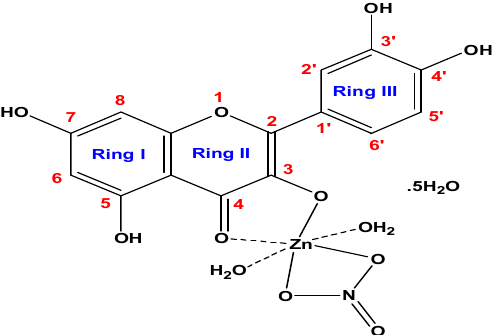
Figure 2. Chemical structure of the Zn/Q complex [17].